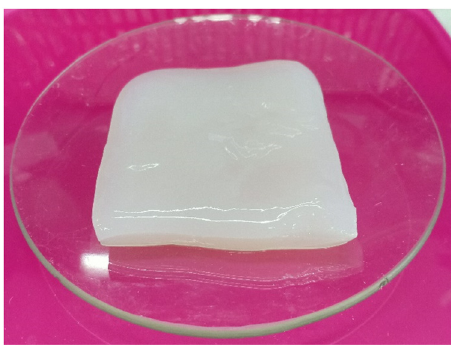
Figure 1: Bacterial cellulose nata de coco fermented for 4